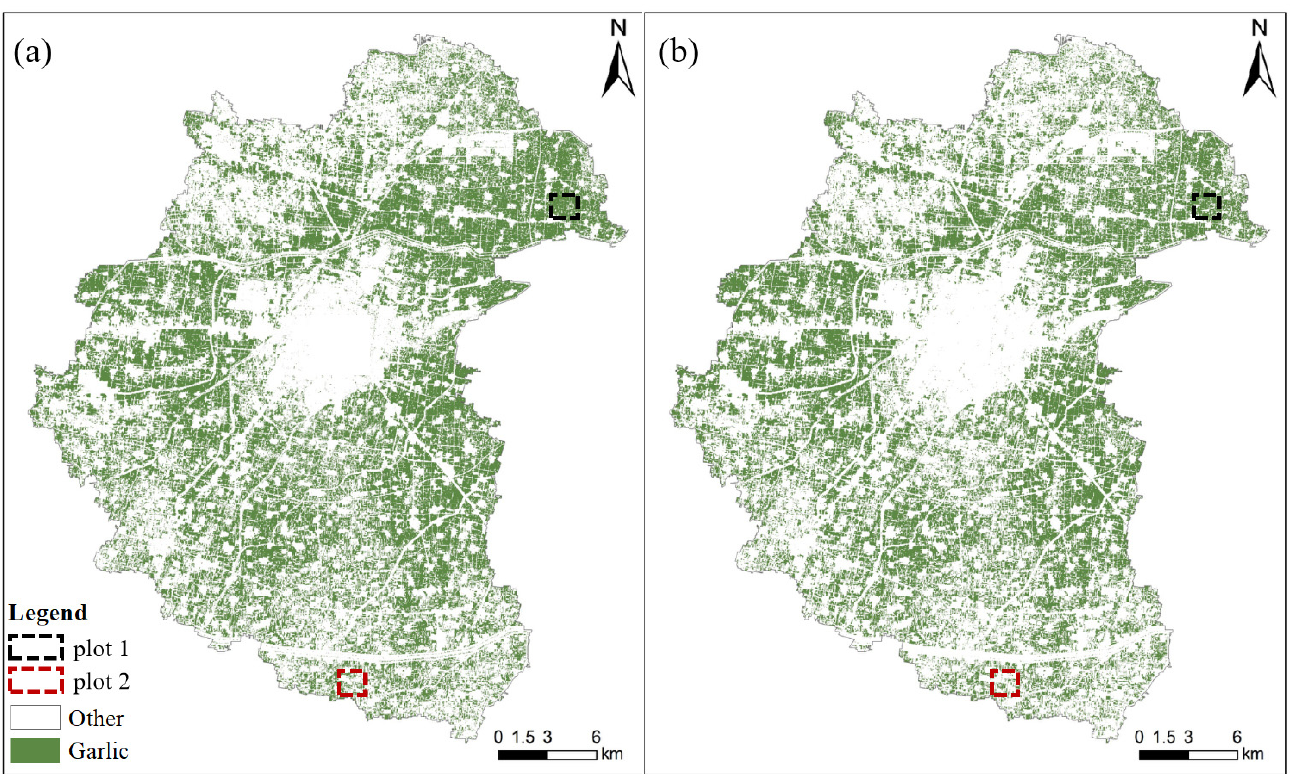
Figure 8. Garlic extraction results with ( a ) Scheme VI and ( b ) Scheme I.